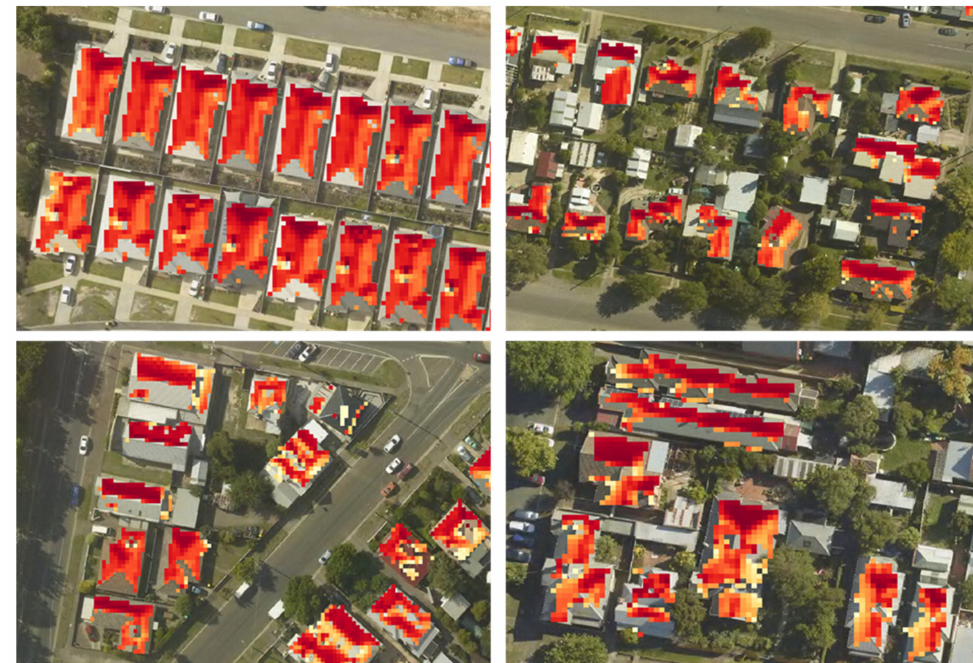
Figure A2. Sample of computed solar radiation on roofs.